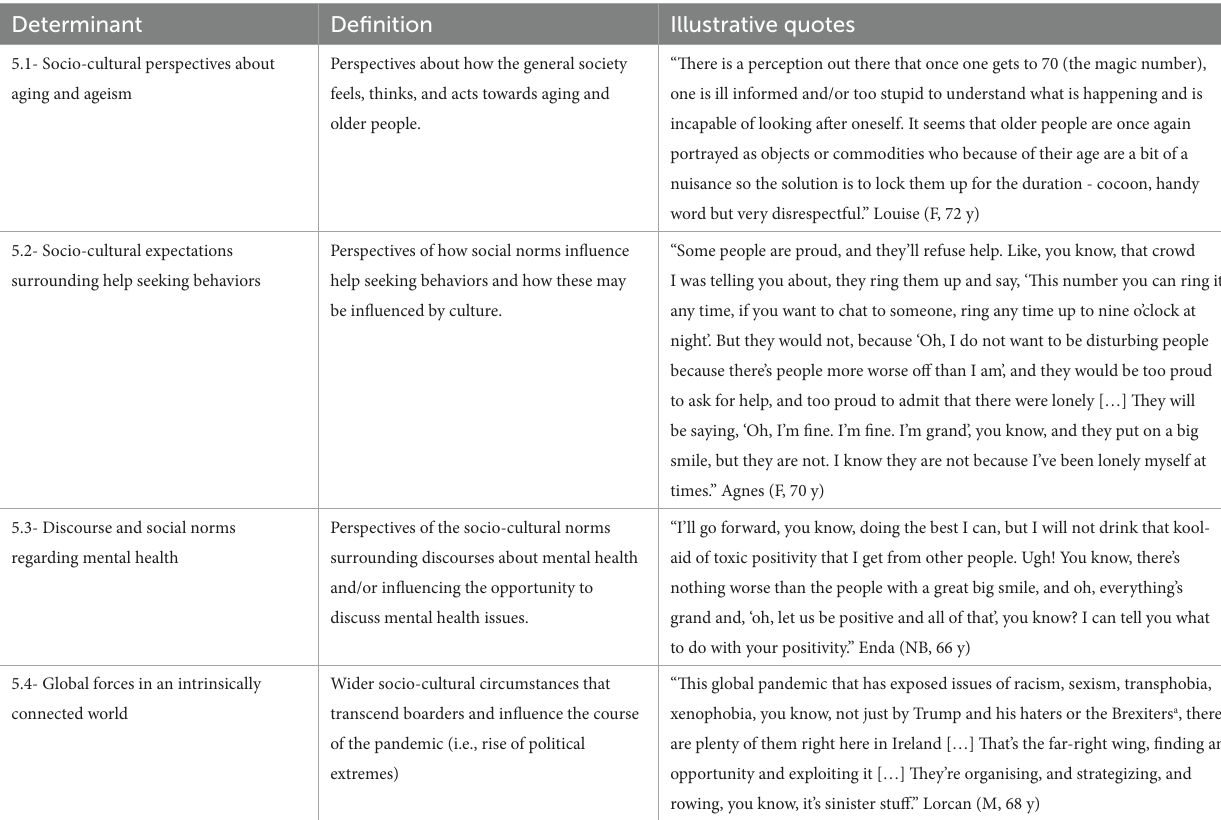
TABLE 6 Details of socio-ecological determinants at the macro-system